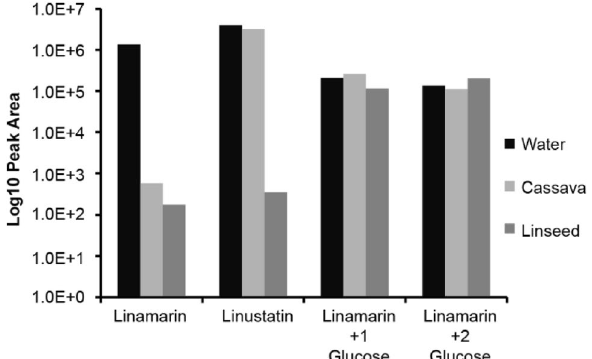
Figure 4. Resistance of glucosylated linamarin derivatives to activation by plant enzymes with release of hydrogen cyanide. The cyanogenic monoglucoside linamarin, the cyanogenic diglucoside linustatin and the glucosylated linamarin derivatives found in the honeydew of whiteflies fed on cassava were tested. Honeydew and standards were incubated with crude enzyme extracts from cassava and linseed or with water alone. Linamarin was readily hydrolyzed by both cassava and linseed extracts, and linustatin was hydrolyzed by linseed enzymes. Conversely, the insect-derived glycosides were not substrates for either of the enzyme